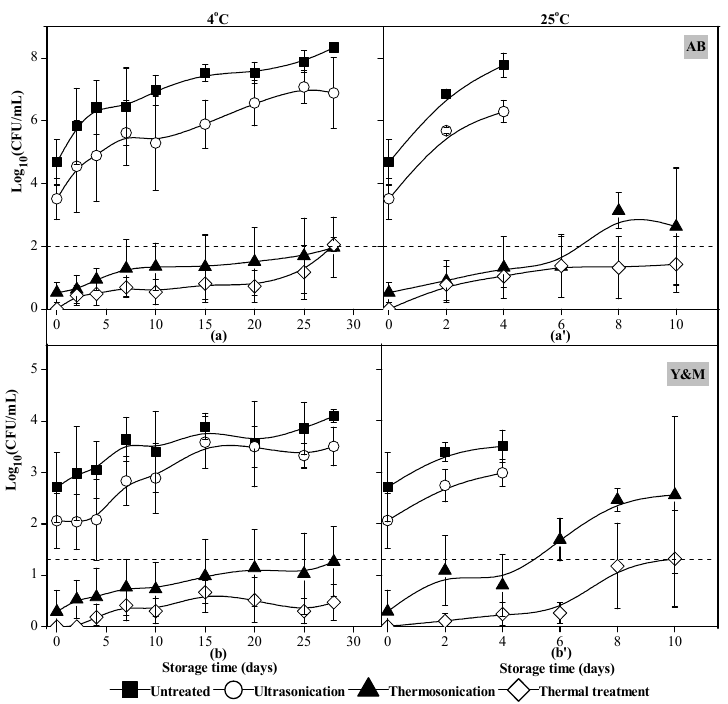
Figure 2. Changes of aerobic bacteria ( a , a’ ), yeast and molds ( b , b’ ) in red pitaya juices during storage at 4 °C and 25 °C, as subjected to thermosonication (475 W, 56 °C, 20 min), ultrasonication (475 W, 10 °C, 20 min), and thermal (83 °C, 1.5 min) treatments. Dotted lines were the acceptable limit defined by GB 7101-2015 [23].